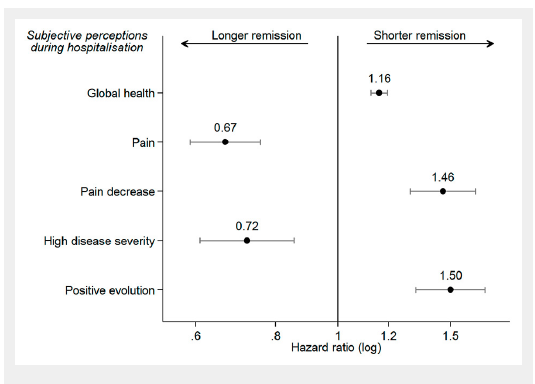
Figure 2 Hazard ratios (HRs) for the final model (n = 807). For health, pain and pain evolution, the HR refers to increments of two standard deviations. An HR above 1 shows an increased probability to be considered fit for work.